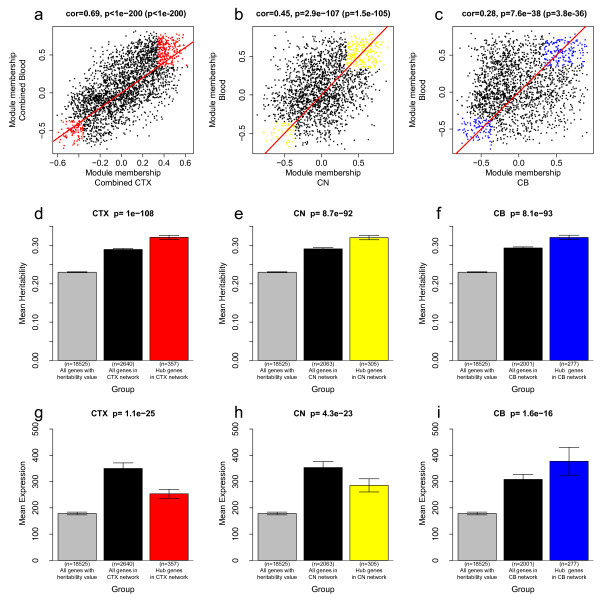
Definition and characterization of preserved intramodular hub genes. The scatterplots show how the combined measure of module membership in blood MM.combined.Blood (or MM.Blood, y-axis) related to the analogous measure in cortex (a), caudate nucleus (b), and cerebellum (c). Preserved intramodular hub genes were defined as those genes whose combined MM measure in blood and brain tissue is larger than +0.35 (or smaller than -0.35), since these genes showed highly significant evidence of being part of the preserved modules in both tissues. For the CTX, CN, and CB networks, the roughly 300 preserved intramodular hub genes are colored in red (a), yellow (b), and blue (c). We report both uncorrected correlation test p-values and Bonferroni corrected p-value (inside of brackets). Barplots (d-f) show the mean heritability of the blood expression profiles (y-axis) across preserved intramodular hub genes (blue bars), across genes in the CTX (d), CN (e), and CB (f) networks (black bars), and across all genes on the blood array (grey bar). Note that the preserved intramodular hub genes have significantly higher mean heritability than non-preserved intramodular hub genes. Barplots (g-i) show the mean blood expression values (y-axis) across the same groups of genes. Note that the preserved intramodular hub genes and the brain network genes have significantly higher mean expression values in blood than all genes on the array (grey bar). However, preserved intramodular hub genes do not have higher mean expression levels than the (roughly 2500) genes that form the brain network (black bars).